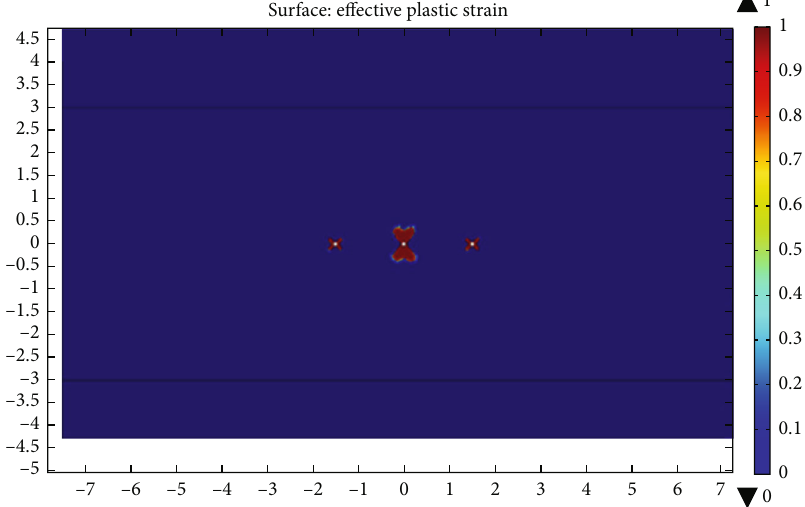
Figure 5: Plastic zone distribution of single-hole fracturing.